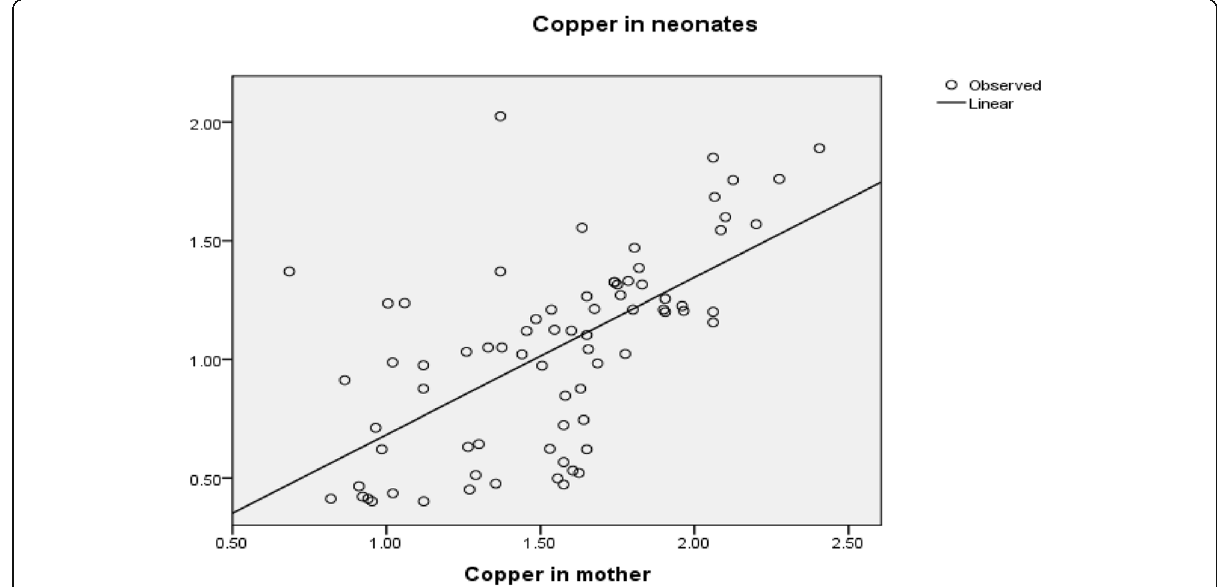
Fig. 2 Correlation between copper level in neonates and copper level in